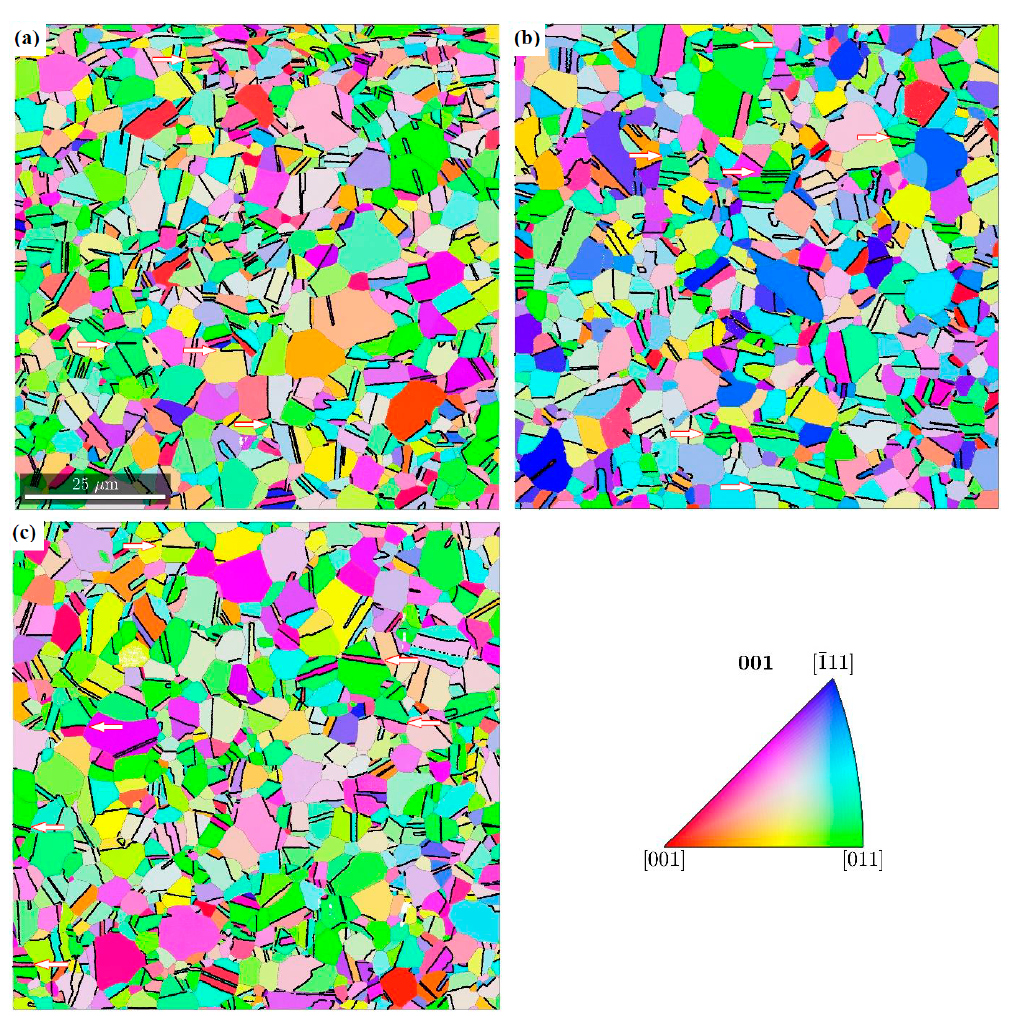
Figure 7. Orientation of austenite grains together with twin boundaries (thick black lines) in areas located at a distance of 4 mm from the fracture surface in specimens stretched at the temperature of 4.2 K ( a ), 77 K ( b ) and RT ( c ). The twins of special orientation are denoted by white arrows.